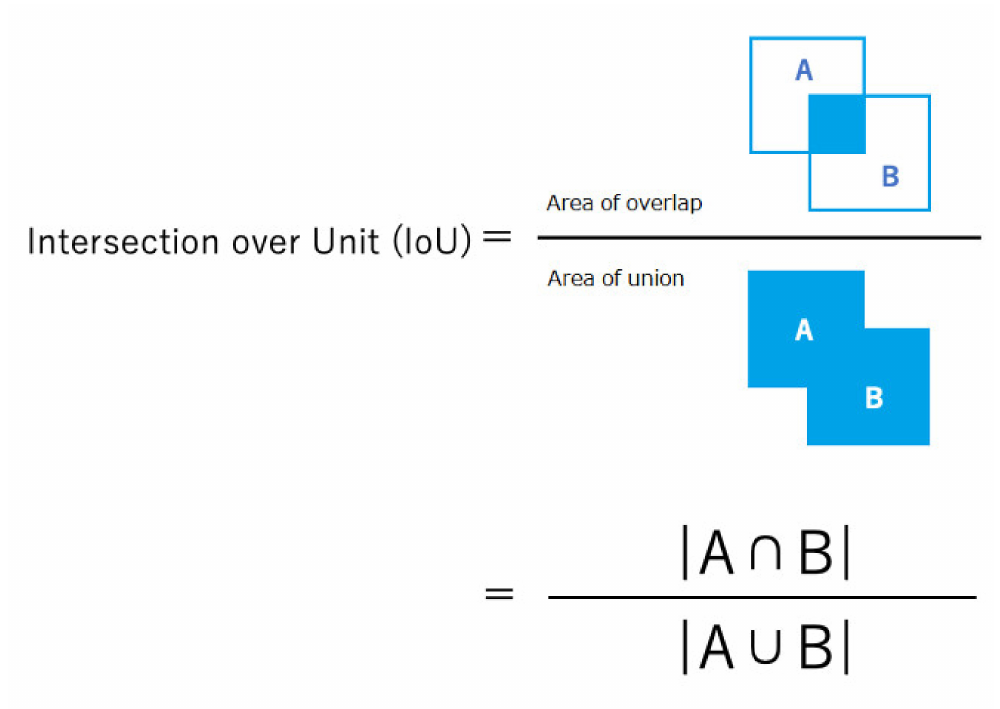
Figure 3. The Intersection over Unit (IoU). The formula of IoU. The IoU is the value between 0 and 1, calculated by dividing the area of overlap with the area of union.